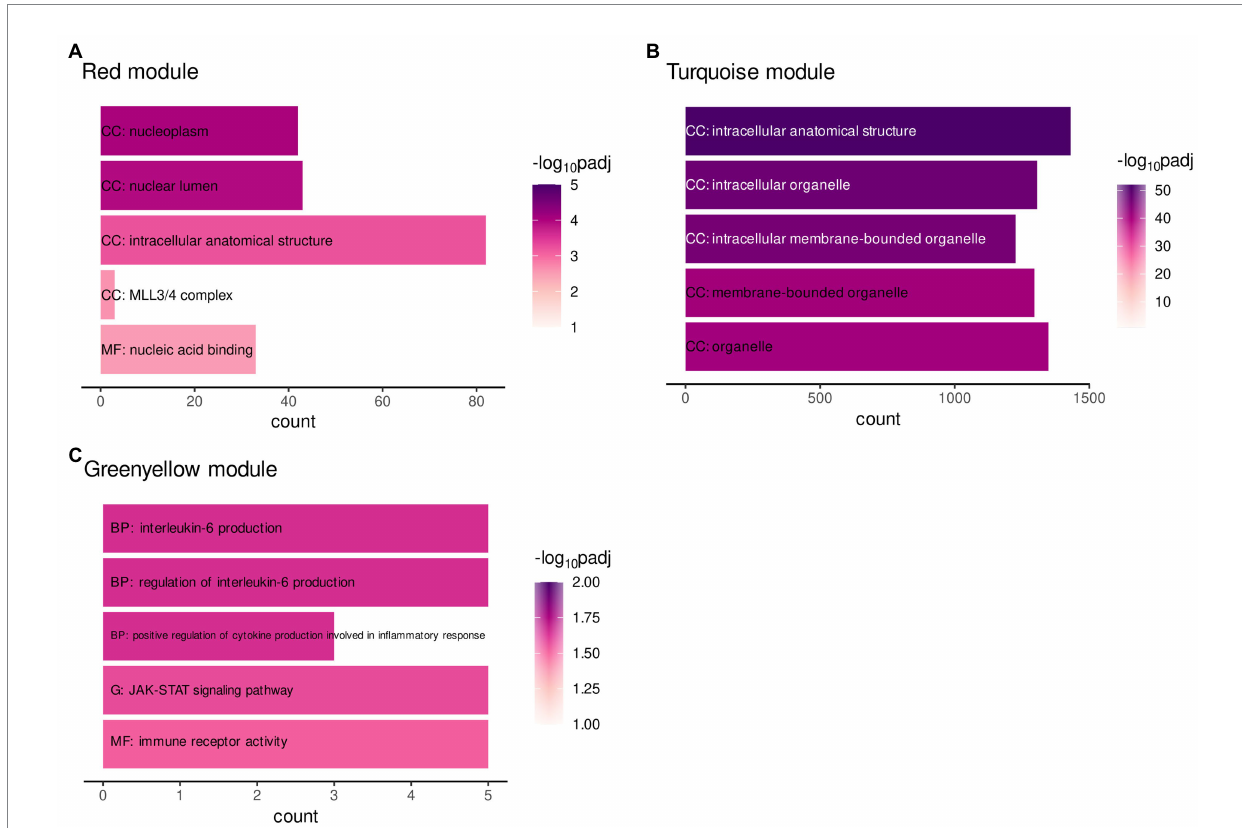
FIGURE 2 Gene functional enrichment of the (A) WGCNA module red, (B) WGCNA module greenyellow, and (C) WGCNA module turquoise. Significance values are color-coded. Abbreviations indicate the database with G: KEGG database, BP: Biological process (GO term), CC: Cellular component (GO term) and MF: Molecular function (GO